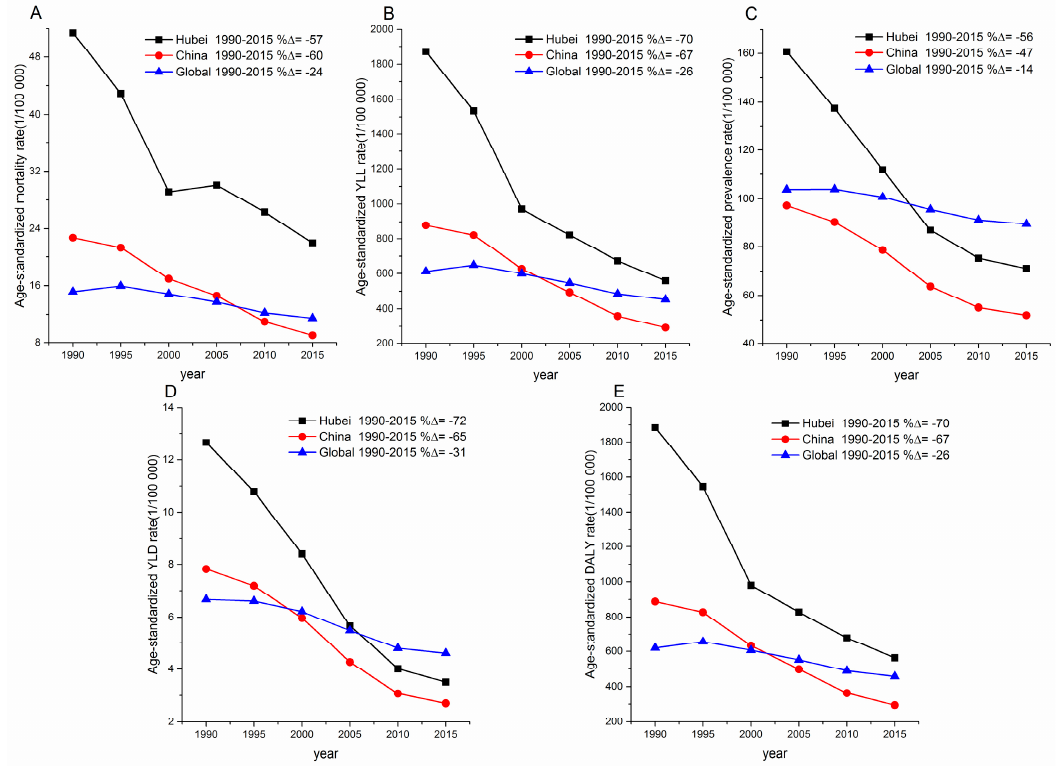
Figure 2. Age ‐ standardized rates for mortality ( A ), years of life lost (YLLs) ( B ), prevalence ( C ), years lived with disability (YLDs) ( D ), and disability ‐ adjusted life ‐ years (DALYs) ( E ) per 100,000 due to self ‐ harm in Hubei, China and globally, 1990–2015. % (cid:4574) = percentage change.